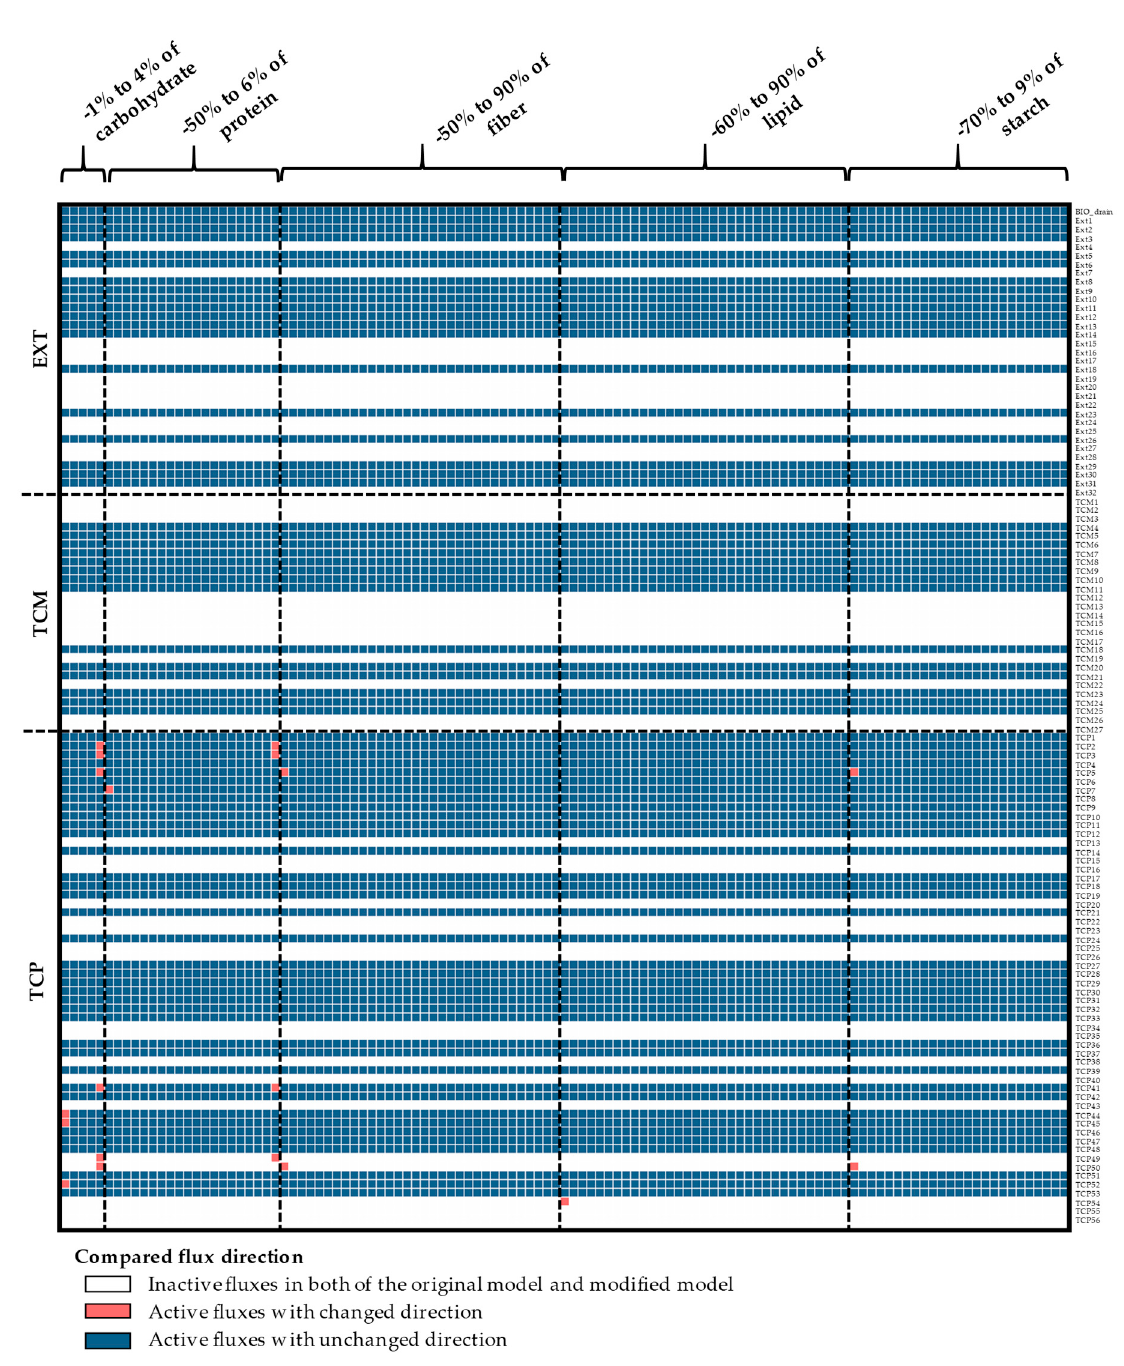
Figure A12. The sensitivity of transport and exchange reaction flux direction to variations in biomass content. Inactive reactions containing zero fluxes are denoted by white-colored grids. Active reactions, non-zero fluxes, with similar flux direction as the original model are denoted by blue grids; while those with dissimilar flux direction (breakpoint) are denoted by red grids. EXC, exchange reaction; TCM, transport reaction between cytosol and mitochondria; TCP, transport reaction between cytosol and plastid.